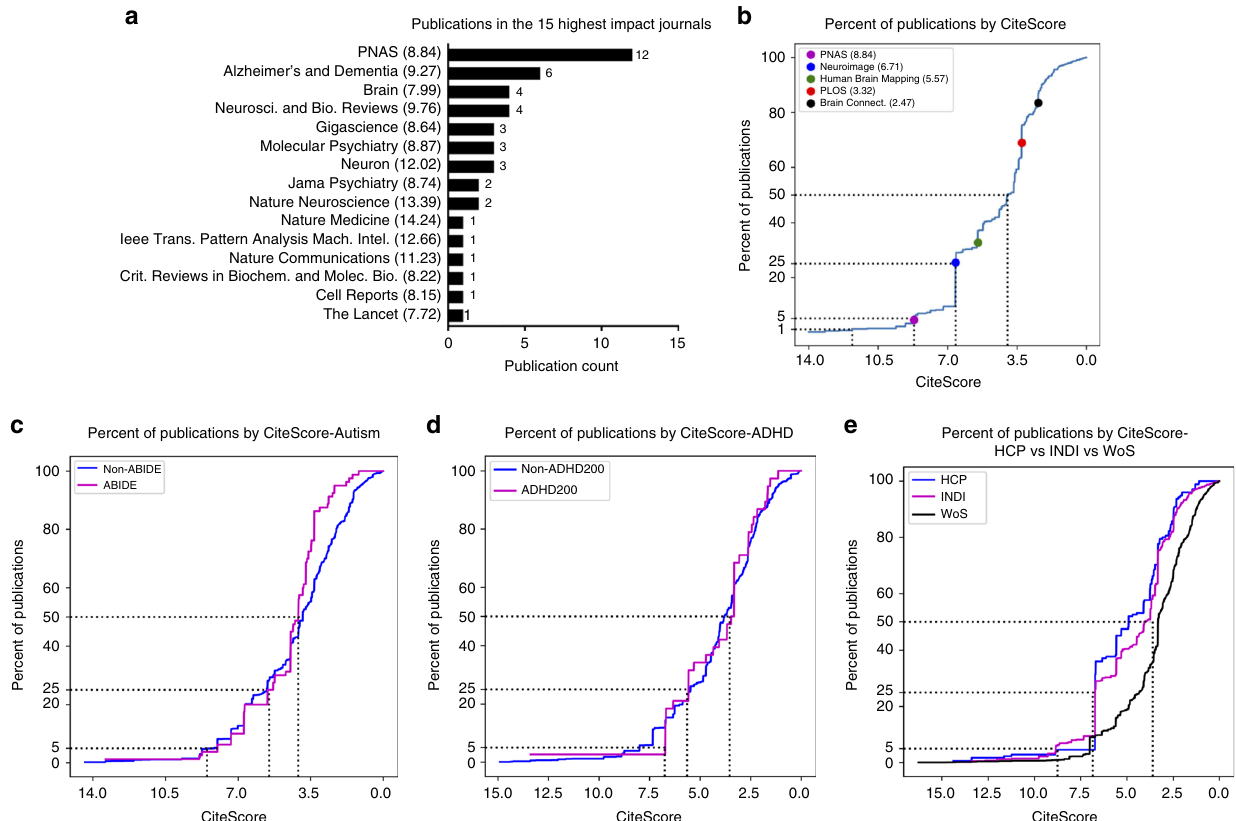
Fig. 2 Estimation of publication impact. a Fifteen highest-impact journals with articles using INDI data sets (based on CiteScore, with the number of publications in each journal). b Cumulative density function (CDF) for CiteScores of publications that used INDI data (select journals are marked to provide reference points to help interpret CiteScores). c CDF comparison for MRI-based publications focused on autism that used ABIDE data versus closed data (one non-ABIDE publication of CiteScore 23.17 was not included in the fi gure for axis consistency). d CDF comparison for MRI-based publications focused on ADHD that used ADHD-200 data versus closed data . e CDF comparison of publications that used INDI data versus the HCP and the larger MRI brain imaging literature, as indexed by Web of Science